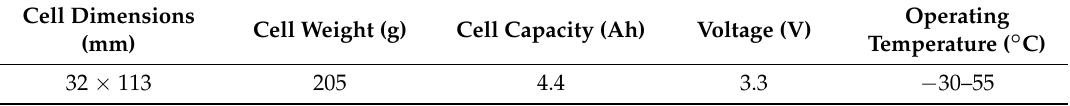
Table 2. AHR32113 Cell Specifications.